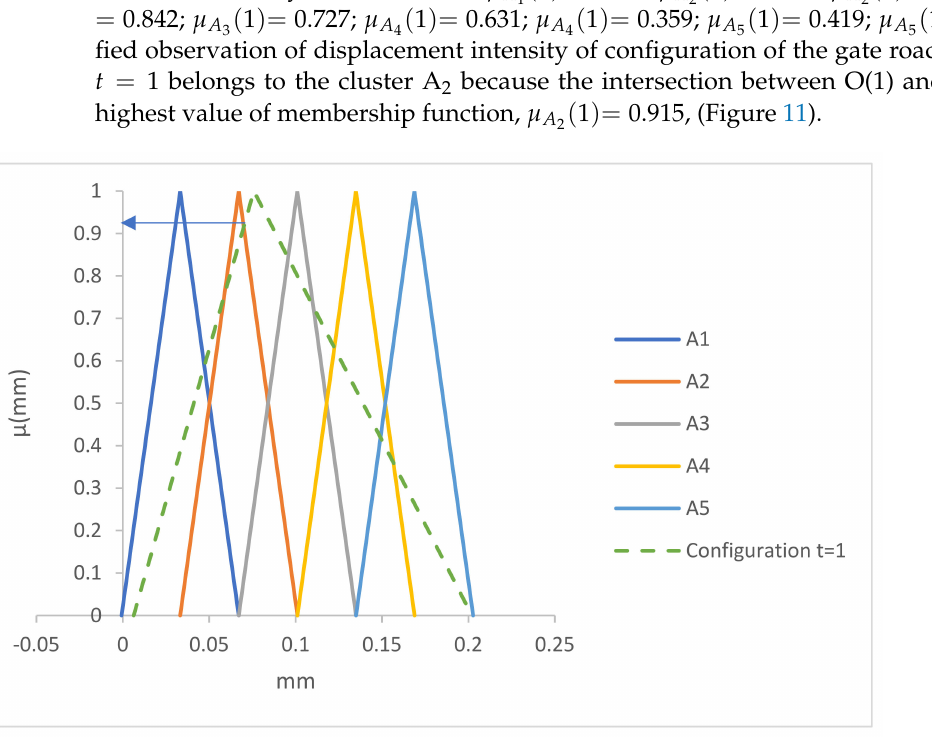
Figure 11. Fuzzy relationships between O(1) and A 1 , A 2 , A 3 , A 4 , and A 5